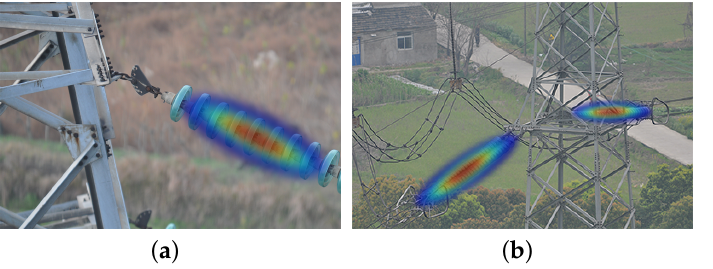
Figure 5. Projection of Gaussian distribution acts on the insulator surface. ( a ) Fitting effect of bivariate Gaussian distribution. ( b ) Fitting effect of bivariate Gaussian distribution on the left side and univariate Gaussian distribution on the right